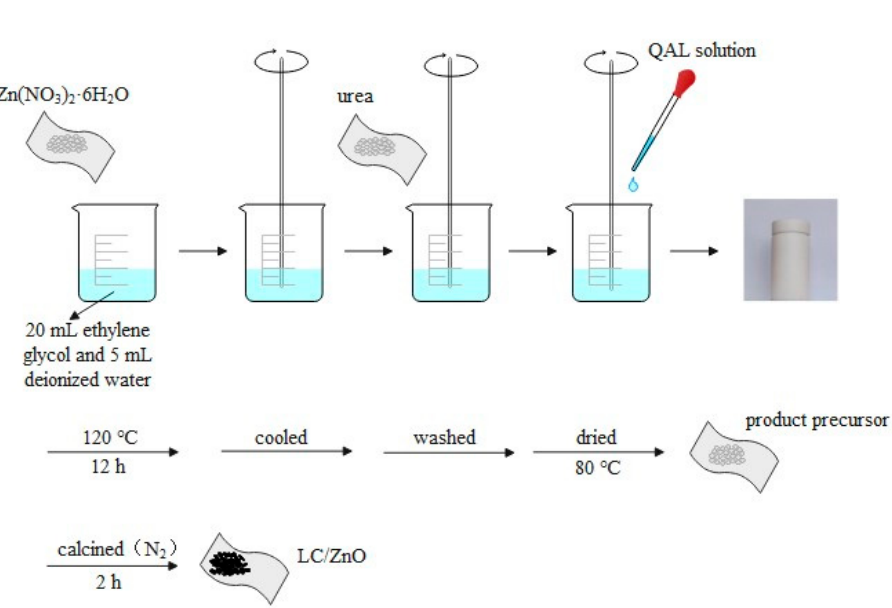
Figure 11. Preparation of LC/ZnO composite material.